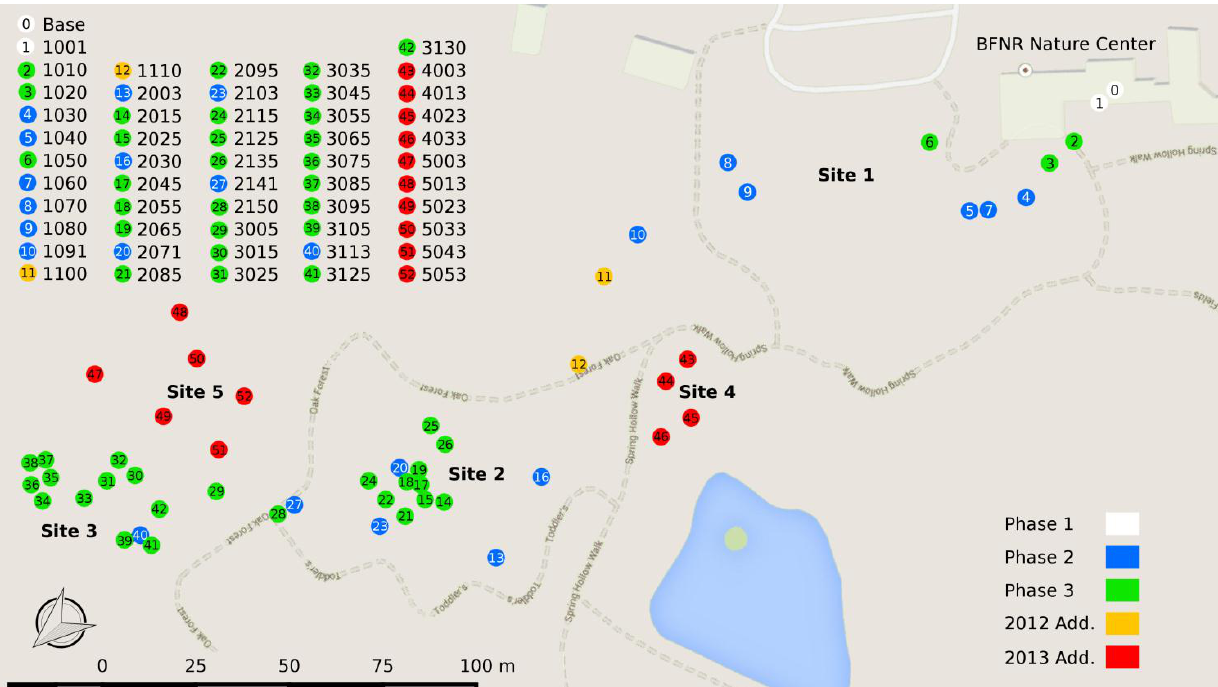
Figure 3. Map of the ASWP testbed (April 2014 configuration). Node 0 ( i.e. , base station) is located within the Beechwood Farms Nature Reserve (BFNR) Nature Center. Nodes are consecutively numbered based on their four-digit node identifier (given in the legend) and colored based on the deployment phase: phase 1 (April 2010, white), phase 2 (June 2010, blue), and phase 3 (July 2010, green). Orange and red colored nodes represent network additions that occurred after phase 3 (2012 and 2013